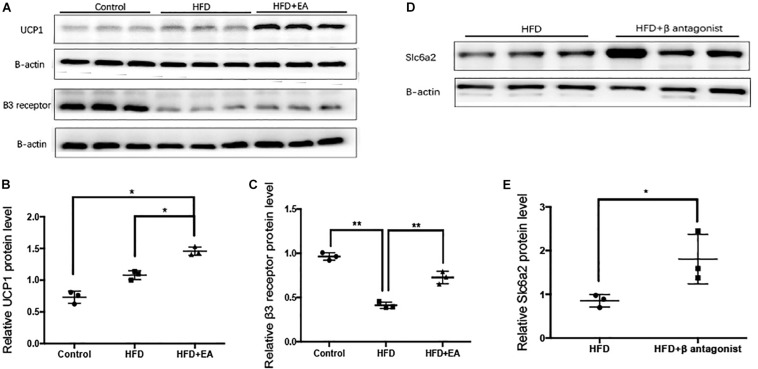
Effect of EA on the thermogenesis-related proteins UCP1 and β3 adrenergic receptor and the NE transporter Slc6a2. (A) Immunoblot image showing UCP1 and β3 adrenergic receptor. (B) Relative protein level of UCP1 (in the control, HFD, and HFD + EA groups) (n = 3, *P < 0.05). (C) Relative protein level of β3 adrenergic receptor (in the control, HFD, and HFD + EA groups) (n = 3, **P < 0.01). (D) Immunoblot image showing Slc6a2 expression in the HFD group and in the HFD group that was administered a β3 adrenergic receptor antagonist. (E) Relative protein level of Slc6a2 (in the HFD, and HFD + β antagonist) (n = 3, *P < 0.05).